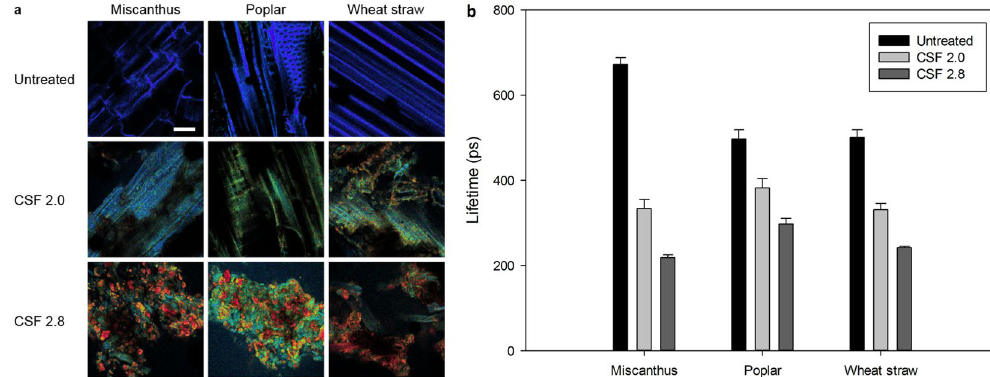
Figure 4. Fluorescence properties of untreated and pretreatd samples. ( a ) Spectral image of autofluorescence after a bi-photon excitation at 750 nm, emission measured from 420 nm (blue) to 722 nm (red); scale-bar is 10 µ m. ( b ) Fluorescence lifetime of untreated and pretreated samples. Fluorescence lifetime values are averaged from measurements on three different